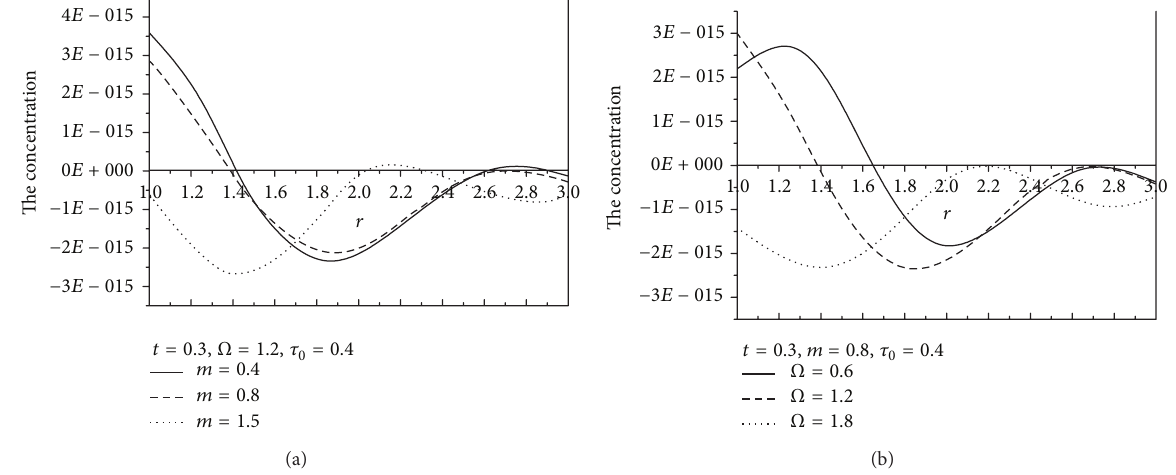
Figure 2: Variation of concentration 𝐶 with radius 𝑟 (thermoelastic diffusion nonhomogeneity